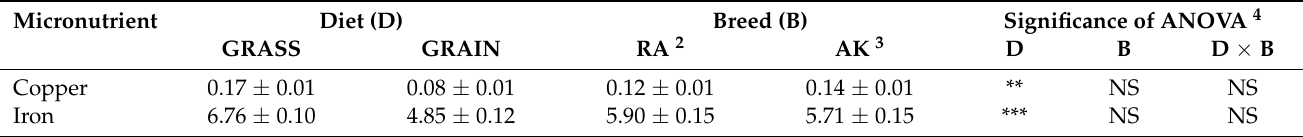
Table 4. Diet, breed, and interaction effects on micronutrient content of beef (mg per 100 g of beef) 1